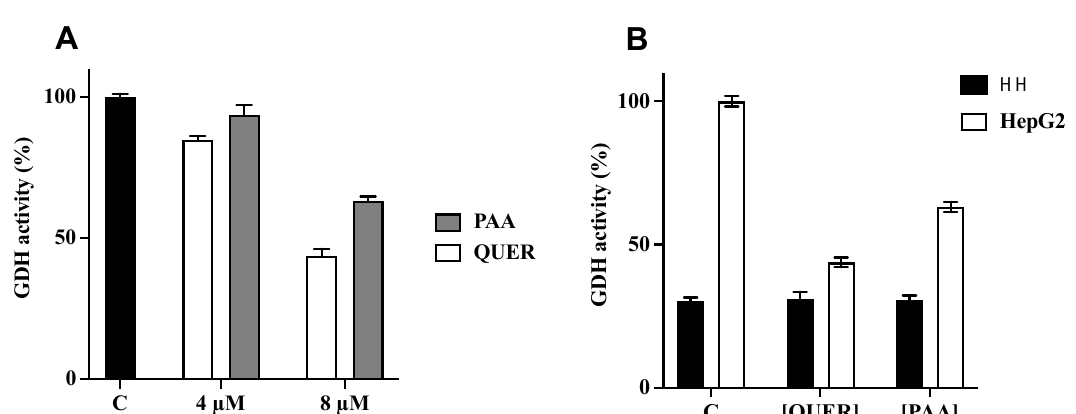
Figure 6. Inhibition of hGDH activity: ( A ) The activity of GDH was evaluated on cellular extract of HepG2 cells. The reaction was started by adding NH 4 Cl without (black column) or with 4 and 8 µ M of Quercetin (QUER, white columns) or PAA (grey columns). The residual activities (%) in the presence of quercetin or PAA are the means ± SD of at least three independent experiments. ( B ) Effect of Quercetin and PAA on activity of GDH was evaluated on cellular extract of HepG2 (white columns) or Human Hepatocyte (HH) (black columns). The reaction was started by adding NH 4 Cl without or with 8 µ M of Quercetin (QUER) or PAA. The residual activities (%) in the presence of quercetin or PAA are the means ± SD of four independent experiments. Differences between samples are significant ( p < 0.05, one-way ANOVA). Abbreviations: PAA: Permethylated anigopreissin A, QUER: Quercetin, HH: Human Hepatocytes .